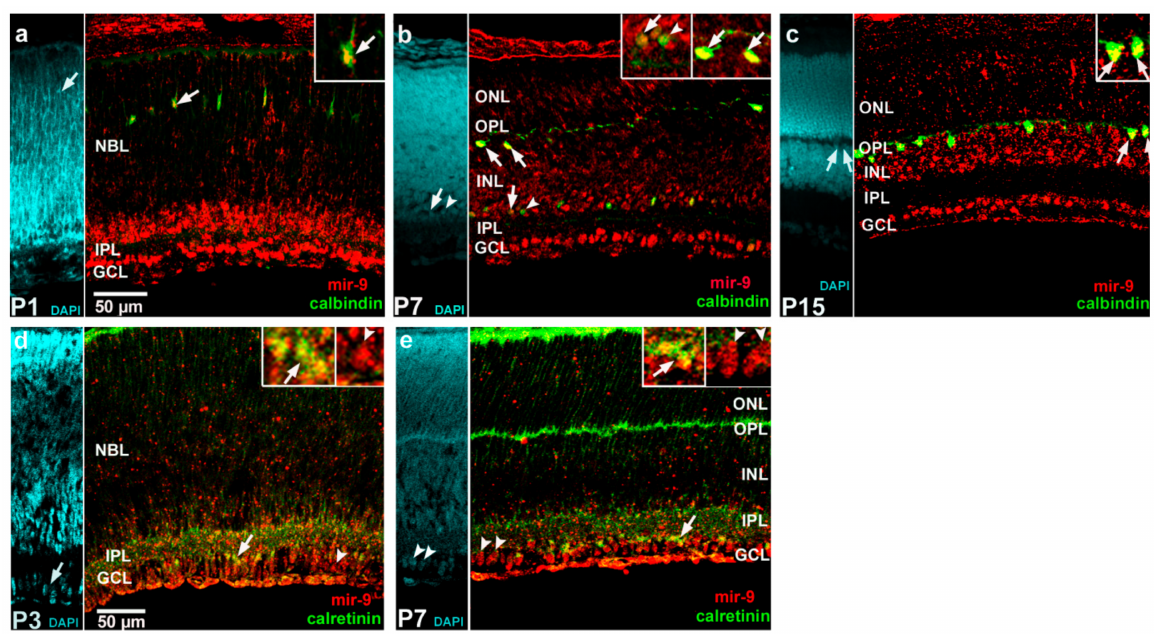
Figure 5. Representative images of miR-9 (red: tyramide signal amplification (TSA) Cy 3) co-detection with neuron-specific marker protein (calbindin D28k or calretinin; green: Alexa Fluor-488) at the indicated postnatal days (mir-9 with calbindin: ( a ) P1; ( b ) P7; ( c ) P15; mir-9 with calretinin: ( d ) P3; ( e ) P7). Insert images demonstrate the overlap or nonoverlap of ISH–dual IHC. Co-localizations are shown by arrows, while non-co-localized cells are demonstrated by arrowheads. The scale bar represents 50 µ m. GCL, ganglion cell layer; IPL, inner plexiform layer; NBL, neuroblast layer; INL, inner nuclear layer; OPL, outer plexiform layer; ONL, outer nuclear layer.